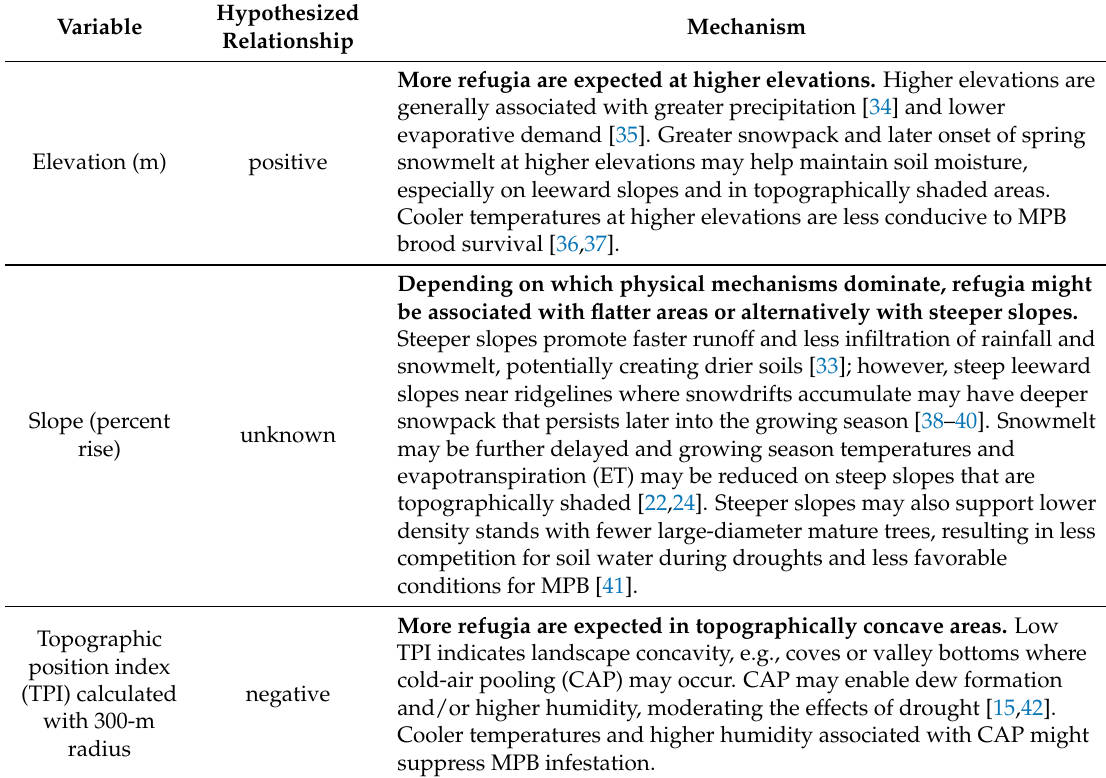
Table 1. Hypothesized relationships between landscape characteristics (topographic, soil, and forest variables) and likelihood of refugia from drought and mountain pine